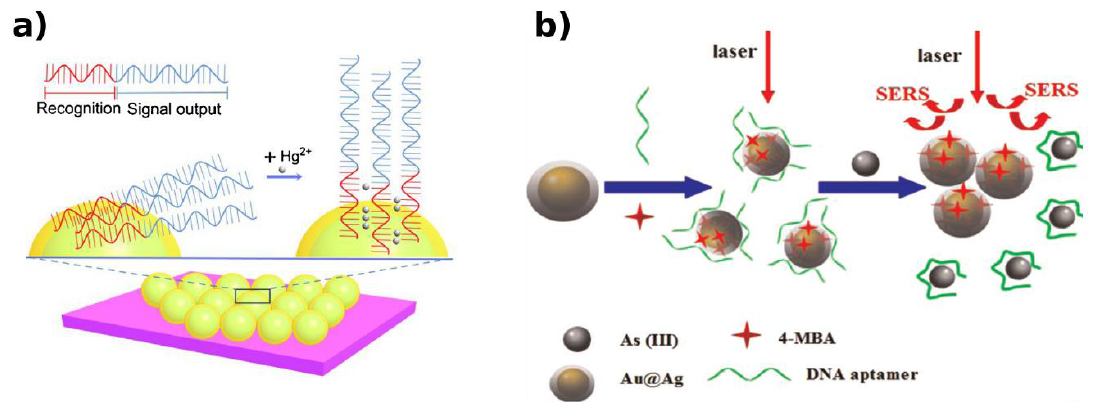
Figure 8. FNAs constructs for SERS-based HM detection. ( a ) Hg 2 + causes a vertical alignment of DNA molecules due to the formation of T–Hg 2 + –T pairs via N–Hg 2 + –N J-coupling bonding, changing respective Raman intensities [113]. ( b ) As 3 + induces the aptamer release from NP surface, inducing NP aggregation and the generation of SERS “hot spots” [112]. Adapted with permission of the Publishers.